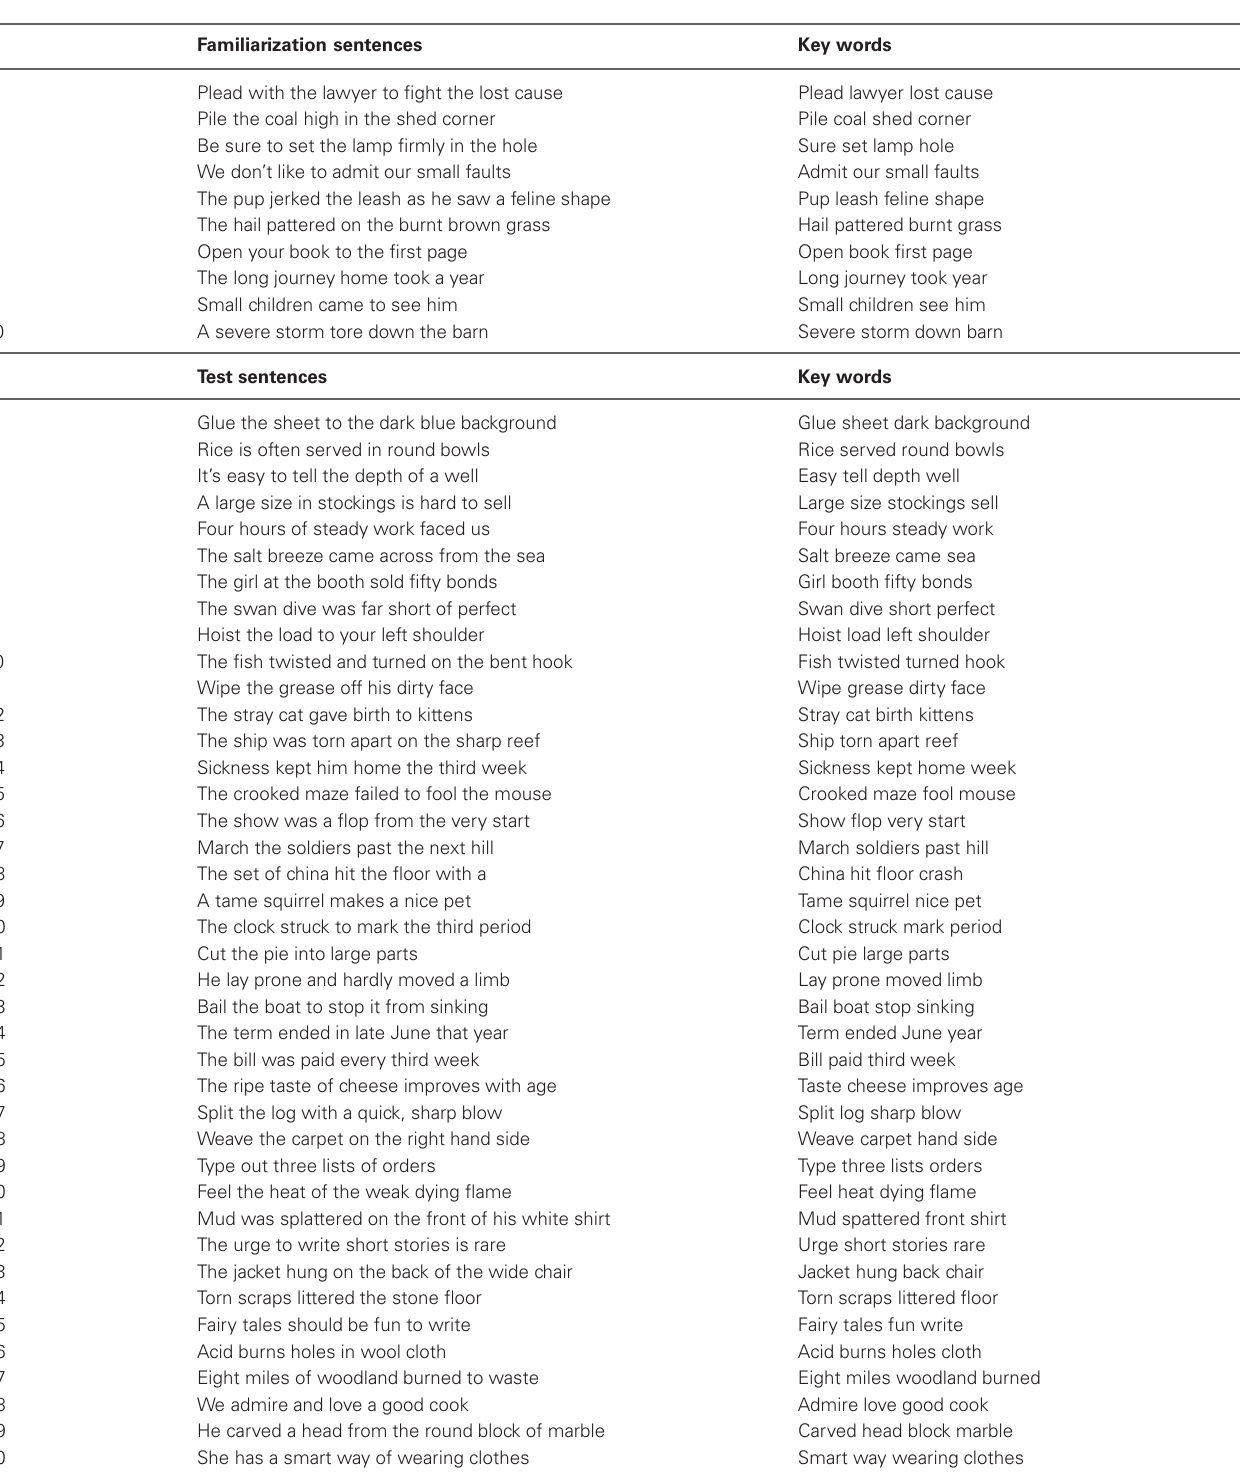
Sentence materials used in the experiment. The 10 familiarization sentences were presented in the order listed across all participants, while the 96 test sentences were randomized across